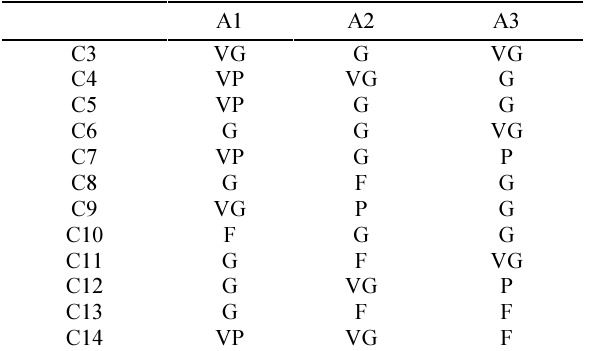
Table 6. A sample of filled questionnaire